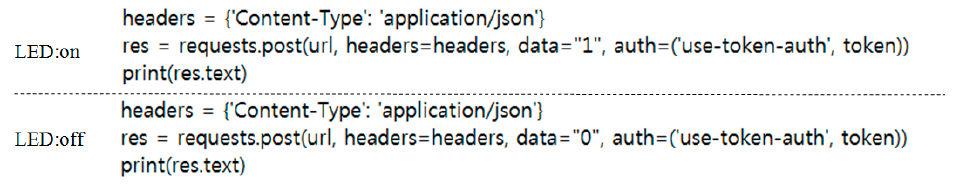
Figure 16. Requests code for LED on/off.